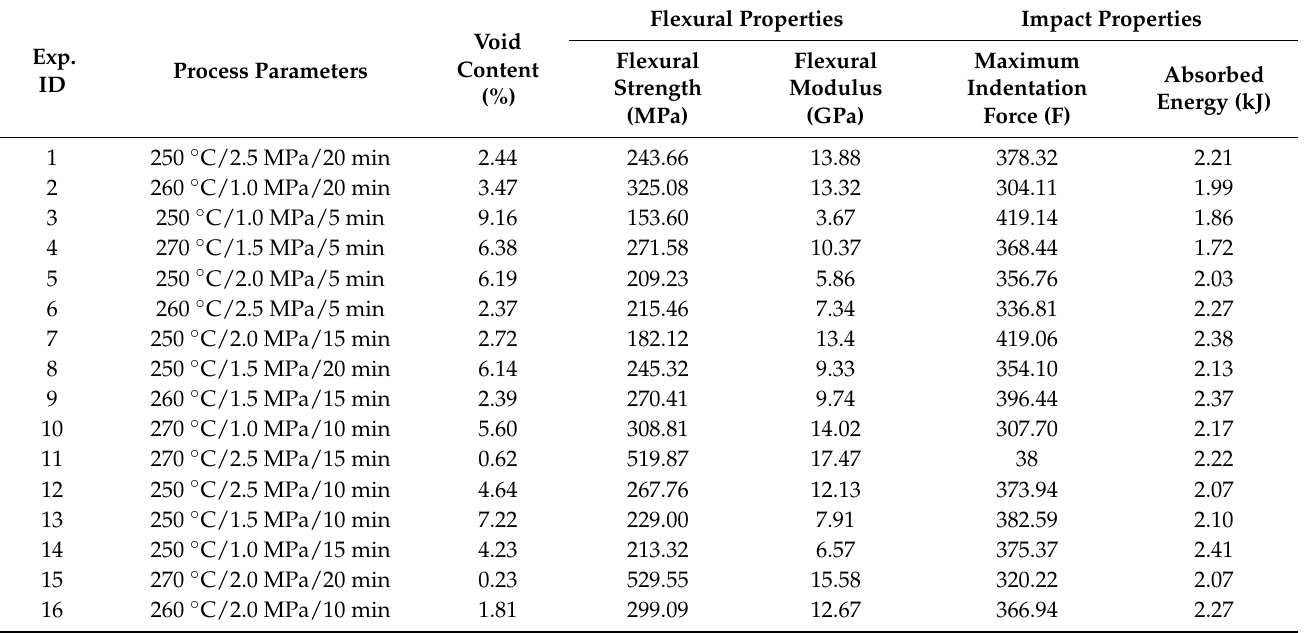
Table 2. Void contents, flexural properties, and impact properties of CF/PA 6 composite laminates.